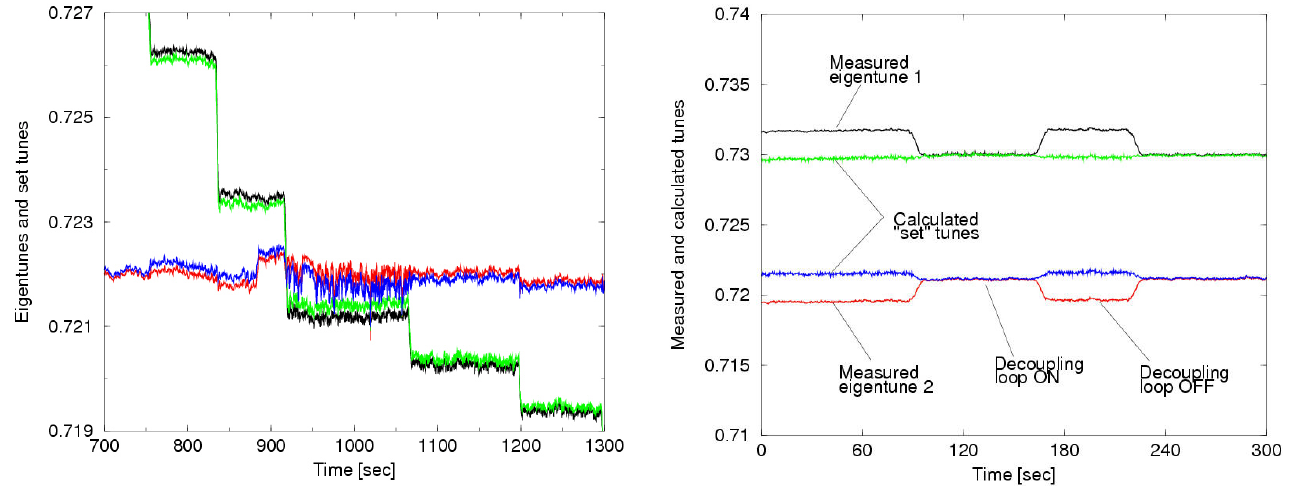
FIG. 12. (Color) Coupling feedback on and off. FIG. 11. (Color) Tune scan showing minimum tune